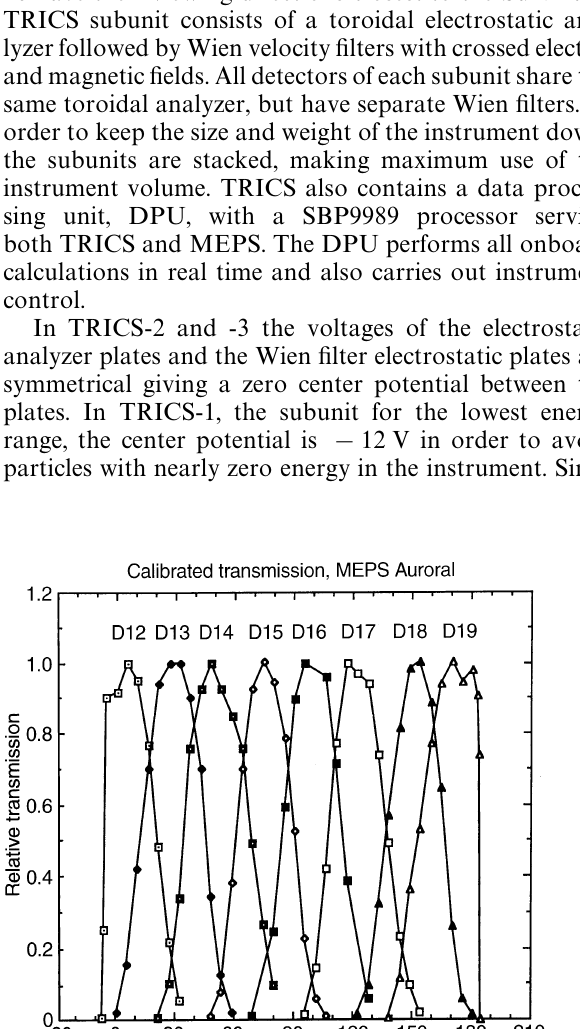
Fig. 1. PROMICS-3. The electron spectrometer MEPS is to the left and the positive ion spectrometer TRICS is to the right . The lower photograph shows the instrument with covers removed. Note the stacked design of the three TRICS toroidal electrostatic analyzers Fig. 3. Calibrated field of view of